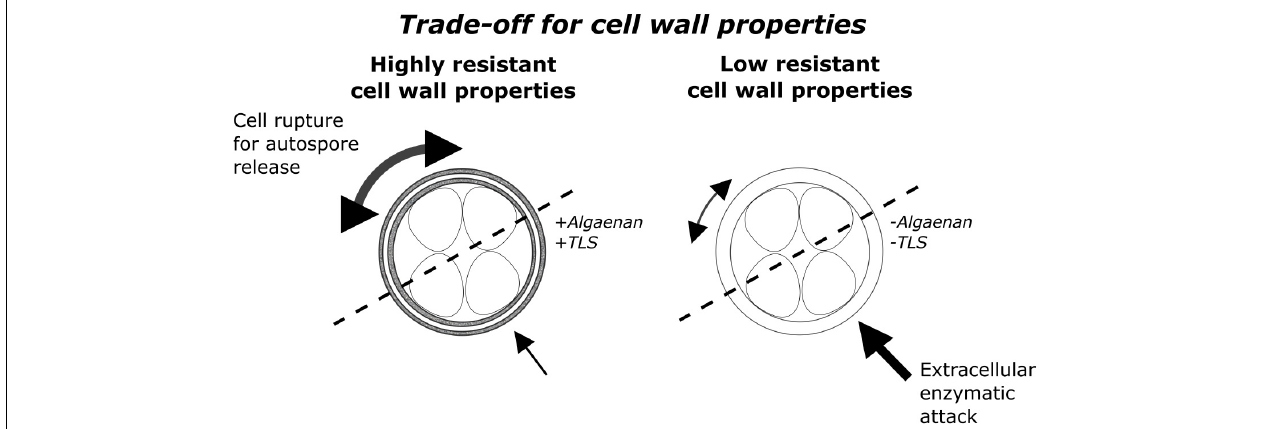
FIGURE 1 | Conceptual visualization of the trade-off between enzymatic attack and multidimensional cellular growth as well as autospore release. On the left side a HR-cell wall structure type with a trilaminar algaenan-containing sheath and on the right side a LR-cell wall structure type with homogenous outer cell wall is